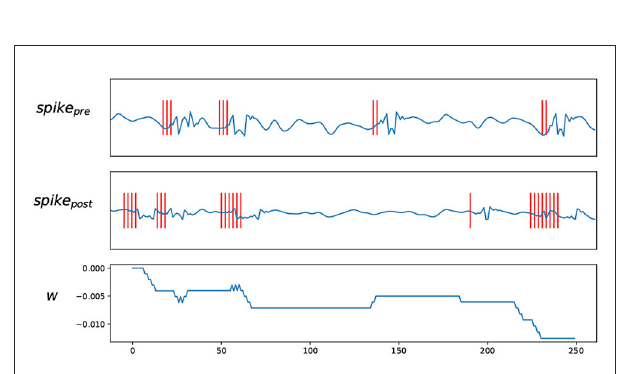
Trace STDP rules. spike pre and spike post are the EEG signals and their spike trains encoded by BSA, W shows how the weights change according to the spike